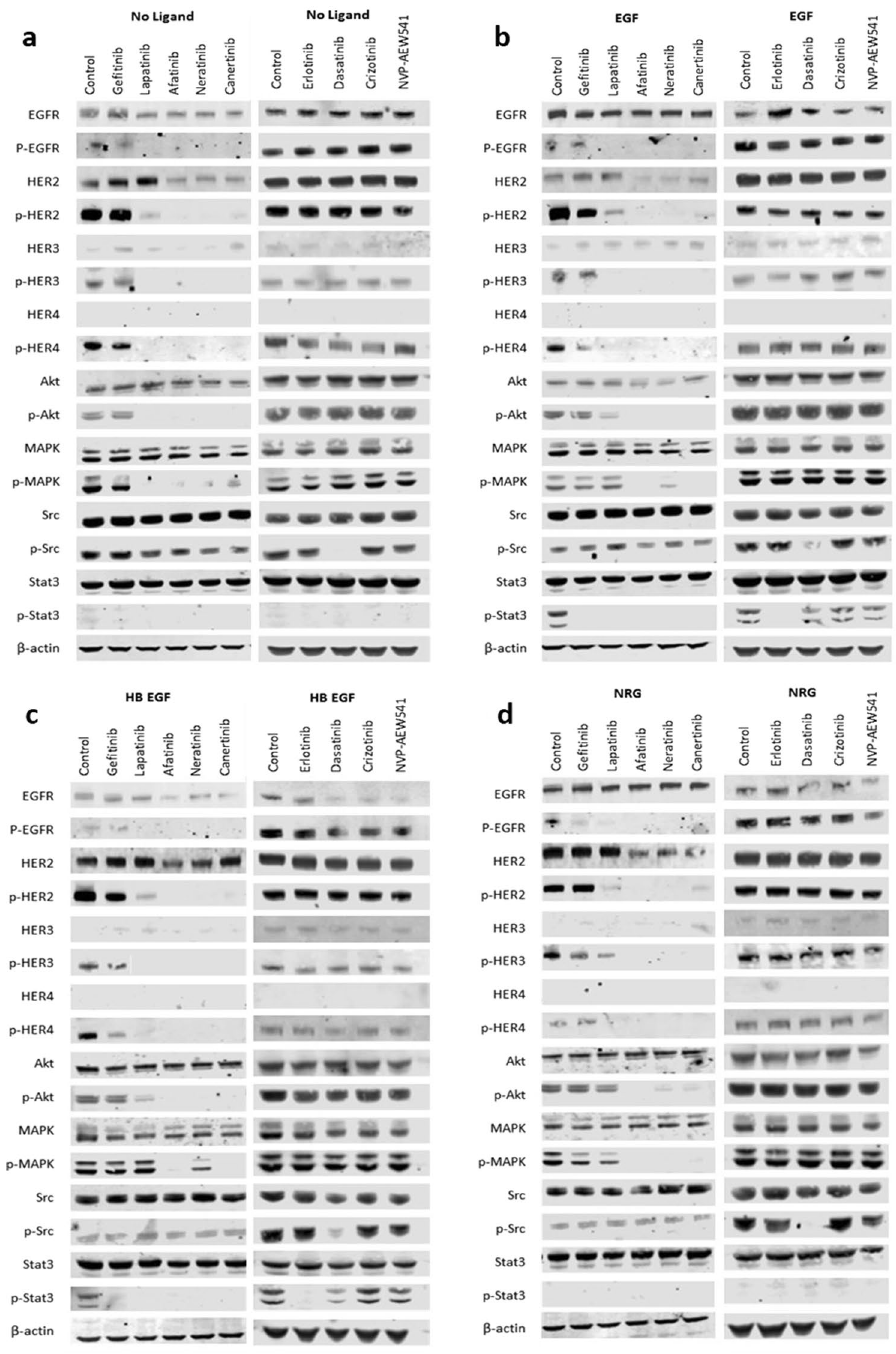
Figure 5. Effects of tyrosine kinase inhibitors on SKBr3 cell lines in the presence or absence of ligands. ( a ) No ligand. ( b ) EGF. ( c ) HB-EGF. ( d ) NRG. Cells were grown in 10% FBS DMEM until nearly confluent, then treated overnight with TKIs at 0.5% FBS DMEM overnight. The next day the cells were treated with 50 nM ligand for exactly 15 minutes before being lysed (with the exception of the control set, which was not treated with any ligand). Proteins were separated using SDS-page electrophoresis, transferred to PVDF membrane and the probed with primary and secondary